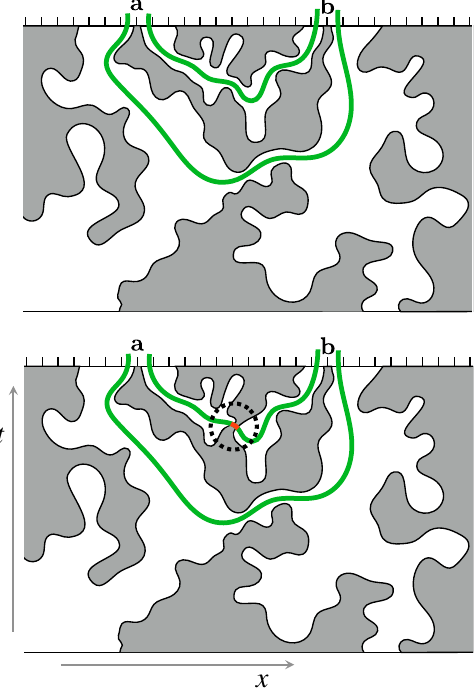
FIG. 11. Decay of the mutual information I 0 between two spins as a function of their separation x , as determined by the classical percolation picture. The main panel shows I 0 ð x Þ for three different values of p . The dashed line indicates the dependence x I 0 ∝ 1 =x 4 expected for p ¼ p at large x . The inset shows the c same data plotted on a semilogarithmic scale. The dashed straight FIG. 12. Examples of minimal-cut configurations for S 0 ð a ∪ b Þ lines in the inset indicate exponential decay, which describes the in cases where I 0 ¼ 2 (upper panel) and I 0 ¼ 1 (lower panel). curves at p ≠ p . All data correspond to system size L ¼ 3 x , with c In the former case, the cost of the minimal cut S 0 ð a ∪ b Þ ¼ 0 , the two spins located at positions L= 3 and 2 L= 3 . Data are and in the latter case, it is S 0 ð a ∪ b Þ ¼ 1 ; i.e., the obstacle averaged over 3 × 10 6 random realizations, and the evolution marked in the upper figure is of minimal width. In both cases, time is t ¼ L . Error bars indicate 1 standard deviation divided by S 0 ð a Þ ¼ S 0 ð b Þ ¼ 1 . the square root of the number of